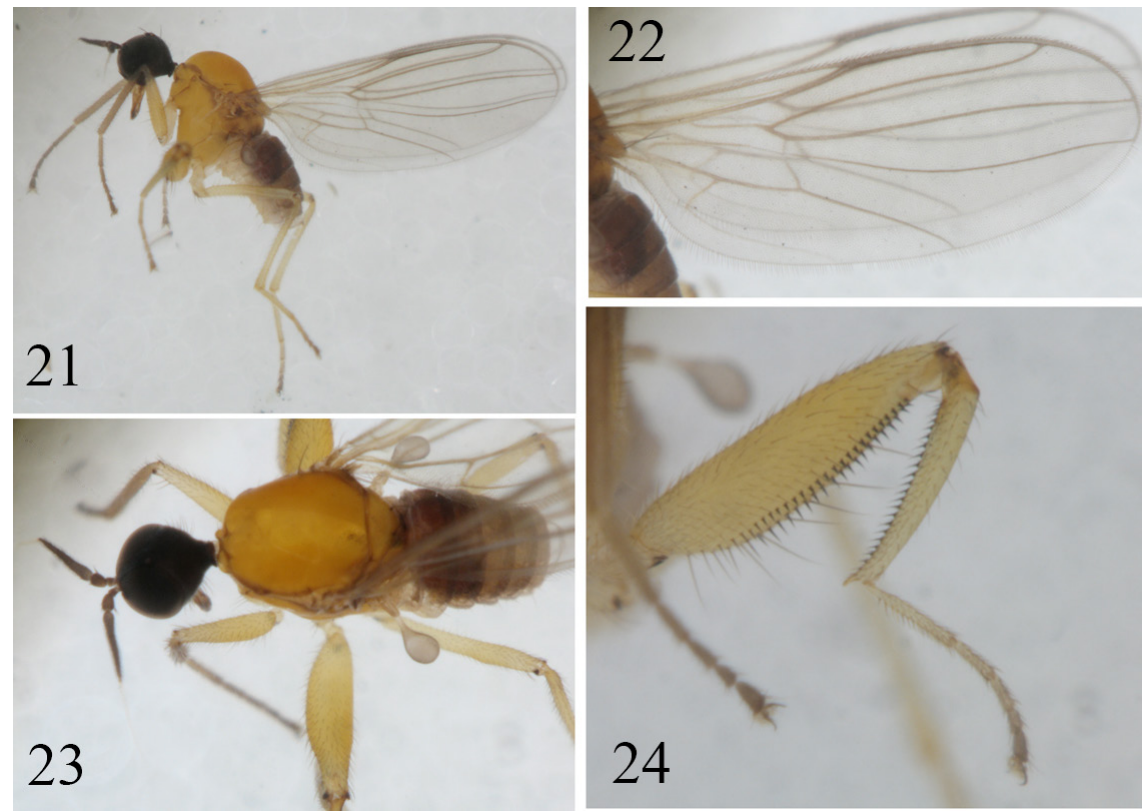
Figs 21–24. Platypalpus manjano sp. nov., holotype ♂. 21 . Habitus, lateral view. 22 . Wing. 23 . Head and thorax, dorsal view. 24 . Mid leg, anterior